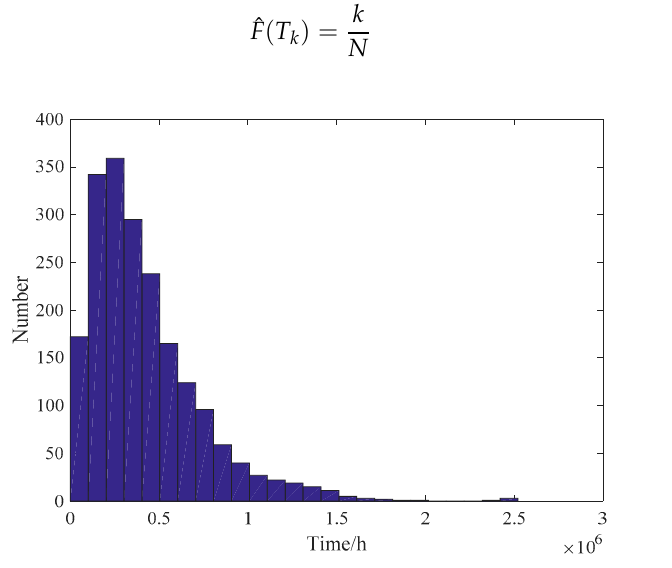
Figure 8. Histogram of time samples.